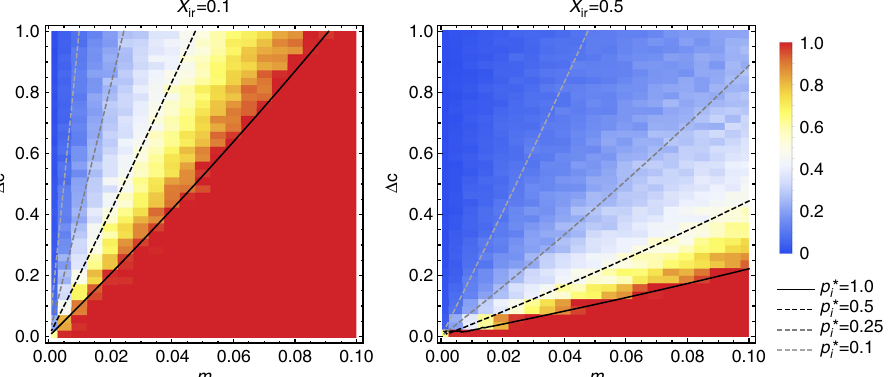
Fig. 2 Equilibrium frequency of the type I trait in the baseline model. The equilibrium frequency of the trait that is initially associated with immigrants (type I) in the baseline model, in relation to the migration rate ( m ) and the difference in cultural conservatism between both types ( Δ c = c r − c i ). Left panel: low interaction probability between individuals with different cultural traits ( X ir = 0.1); right panel: relatively high interaction probability ( X ir = 0.5). Lines depict the equilibrium frequency of the type I trait in the analytical model. For parameter combinations below the solid line ( p (cid:5) the solid line, a stable polymorphism is reached, where the equilibrium frequency of type I is positively related to m and negatively related to Δ c . Note that we only consider migration rates above zero ( m ranges between 0.001 and 0.1). Hence, since there is always a constant in fl ux of type I individuals, the type I trait can reach very low values for low values of m , but can never go fully extinct for any of the parameter combinations. The heat map indicates the results of individual-based simulations. Each coloured block shows the frequency of the immigrant trait after 10 6 events, averaged over 10 simulation runs. Simulations and analytical predictions are in good